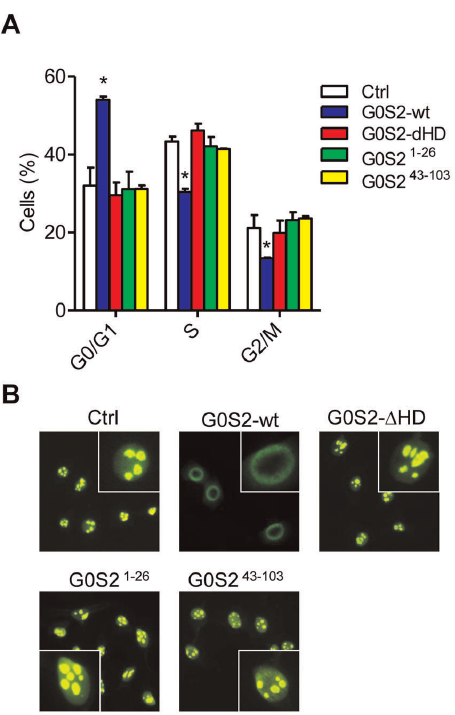
Figure 6. Inhibition of cell proliferation by G0S2 correlates with cytosolic retention of nucleolin. (A) The effects of G0S2 deletion mutants on the proliferation of NIH-3T3 cells were examined by propidium iodine staining and flow cytometric analysis ( n =3). G0S2-wt was compared to G0S2 mutants and empty vector (Ctrl). *, P , 0.05 (two- tailed Student’s t -test). (B) Subcellular localization of endogenous nucleolin was determined by immunofluorescence in NIH3T3 cells transduced with the retrovirus containing full-length G0S2 or the deletion mutants described in Figure 5. The inset shows a higher magnification of a cell presenting nucleolar versus perinuclear localization. The data represent two independent experiments.